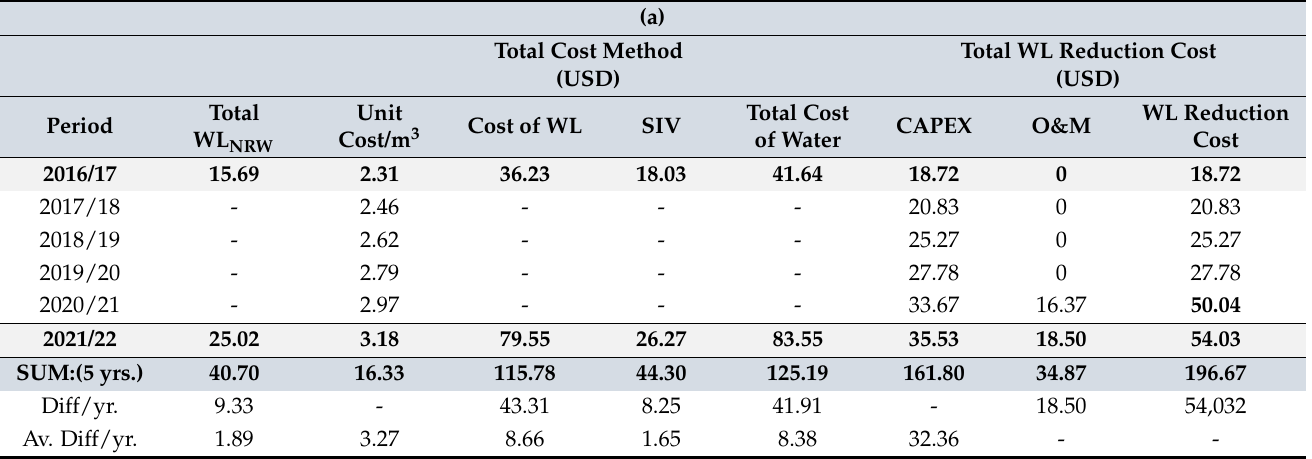
Table 6. ( a ) Preliminary technical water loss reduction investment data; and ( b ) the marginal cost of capital for water loss reduction